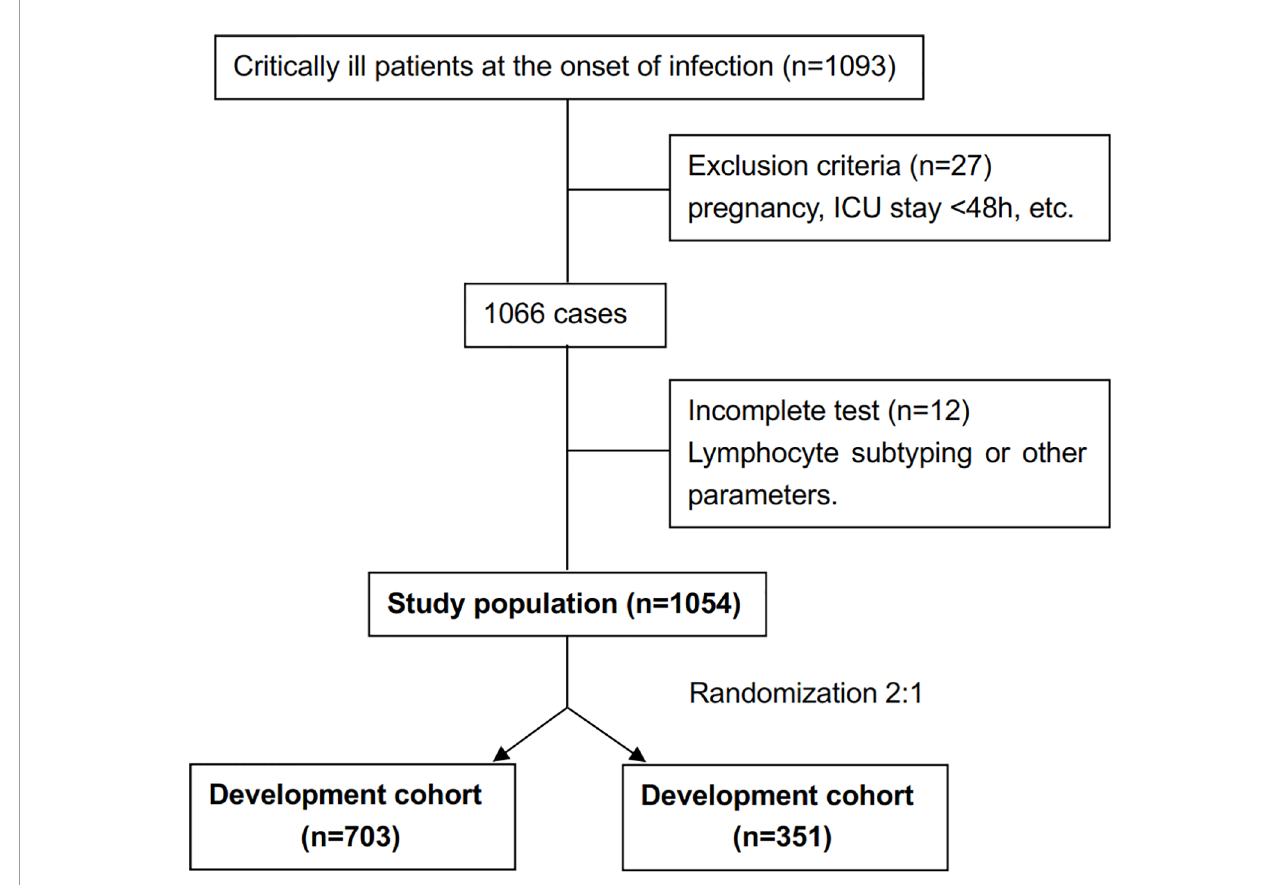
FIGURE 1 | Flow diagram detailing the selection of patients included in the